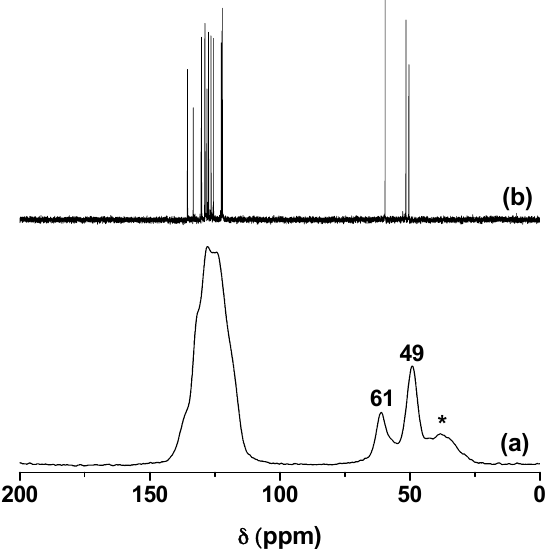
Figure 3. ( a ) Solid state 13 C CP/MAS NMR spectrum of K-NI and; ( b ) liquid phase 13 C NMR spectrum of NI in D 2 O as solvent. Spinning side band is marked by * .